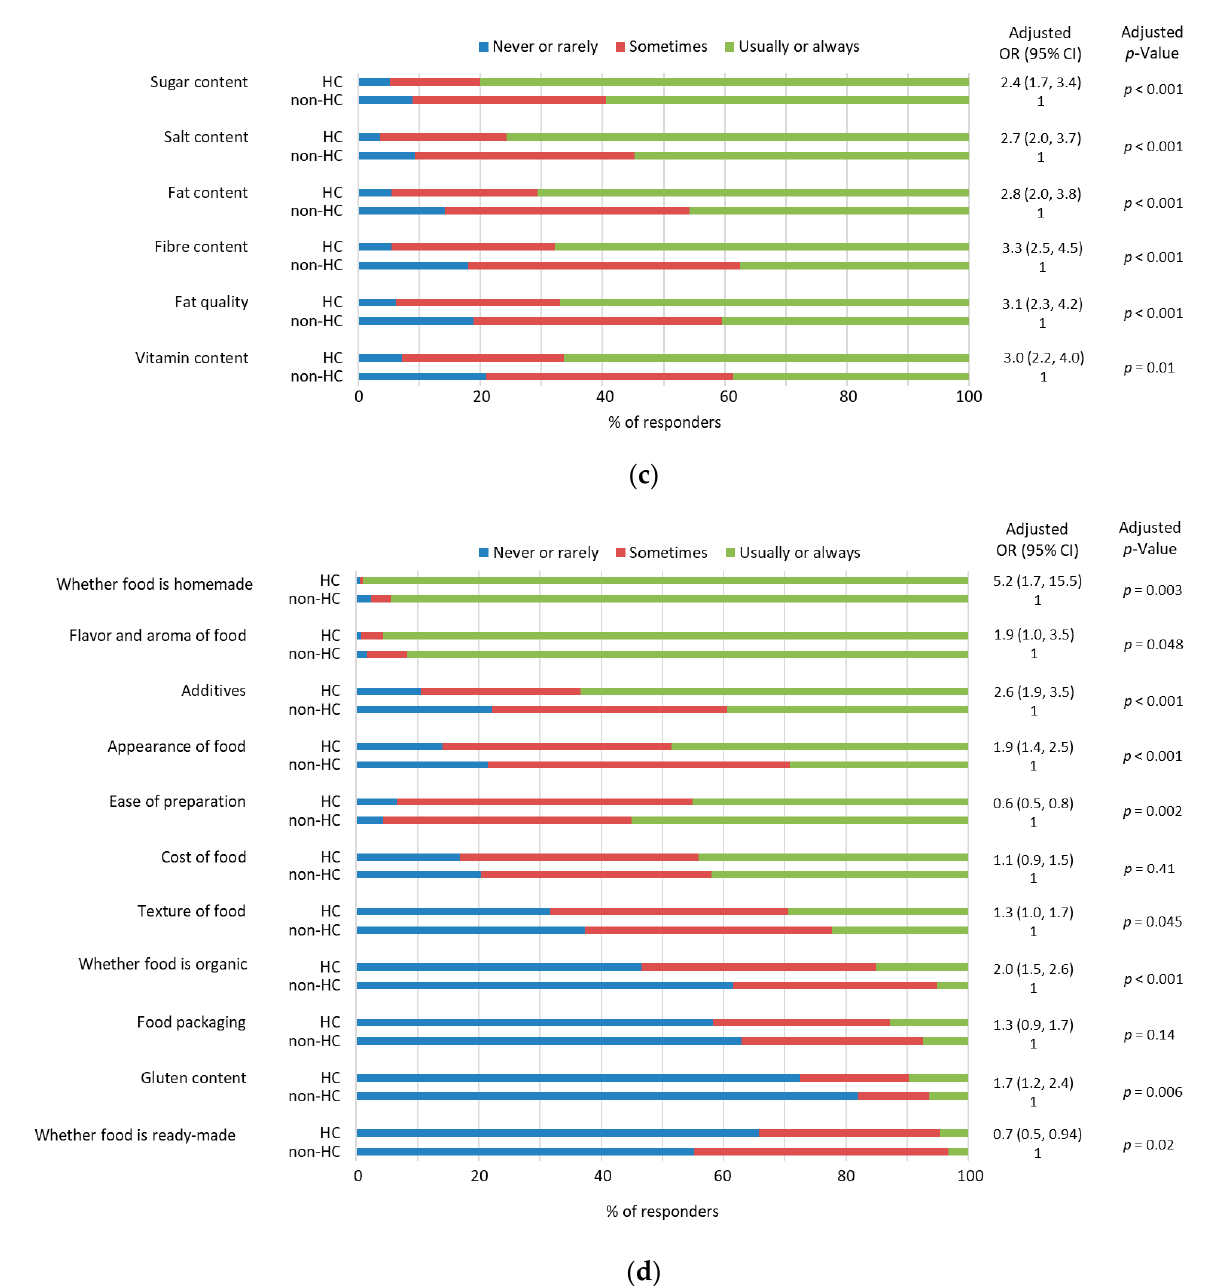
Figure 1. Associations between the parents’ views and parental health consciousness (HC = health- conscious and non-HC = non-health-conscious parents) examined by ordinal logistic regression analyses after adjustment for the parents’ gender, education, and whether the parent had a de-gree in a field of health or nutrition. OR = odds ratio, CI = confidence interval. ( a ) Views on the extent to which they consider factors related to health when feeding their child. Missing data n = 19–27 depending on the question. ( b ) Views on the extent to which they consider factors related to eating behavior when feeding their child. Missing data n = 16–27 depending on the question. ( c ) Views on the extent to which they consider factors related to the nutrient composition of food when feeding their child. Missing data n = 16–18 depending on the question. ( d ) Views on the extent to which they consider factors related to composition, appearance, and preparation of the food they give to their child. Missing data n = 17–19 depending on the question.